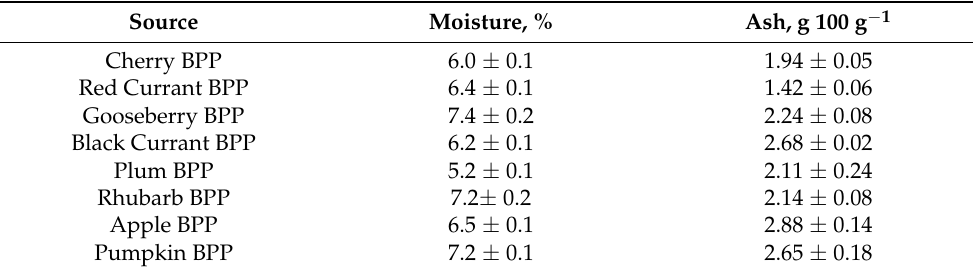
Table 2. Properties of pectin obtained from juice production